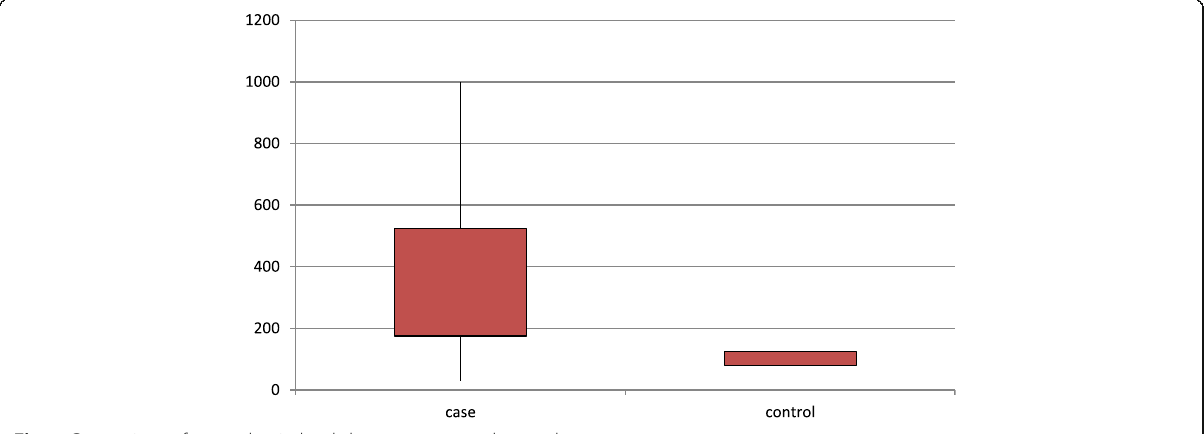
Fig. 1 Comparison of serum leptin levels between case and control groups